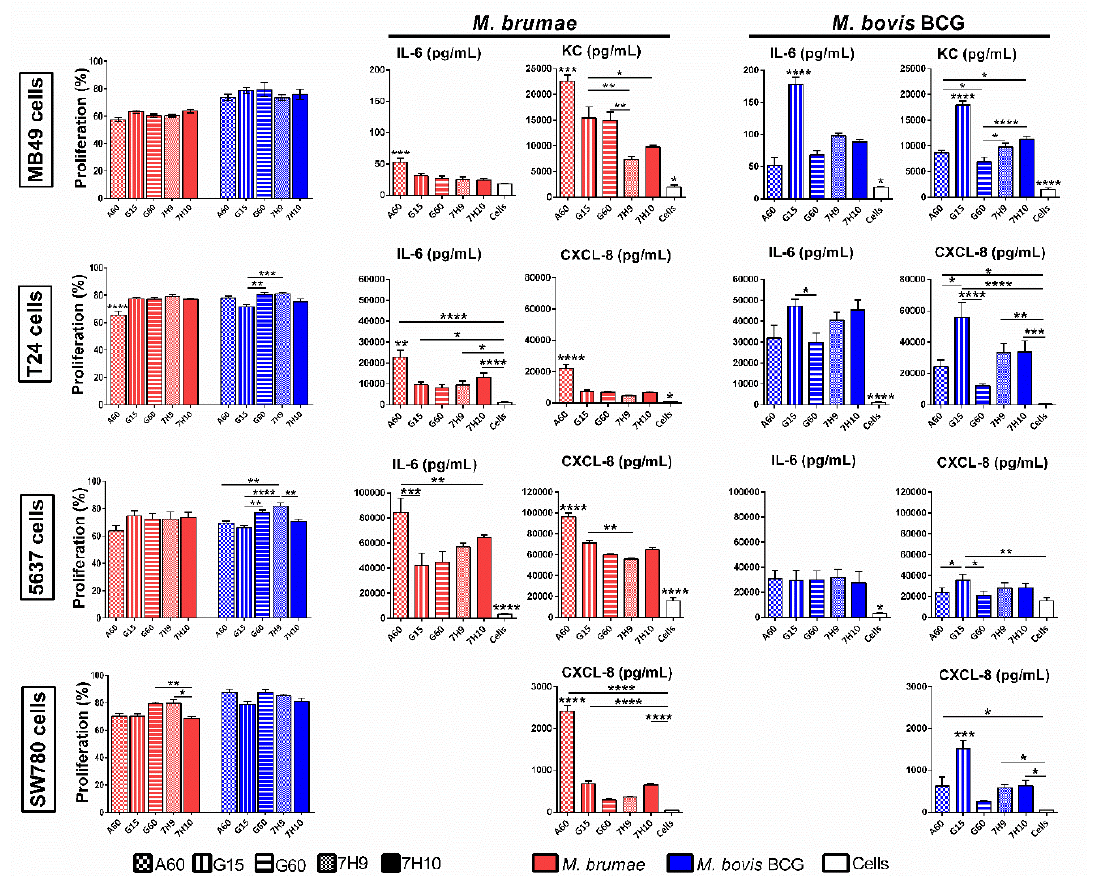
Figure 5. Cell growth inhibition and cytokine production by M. brumae and M. bovis BCG-infected bladder cancer (BC) cell lines. The antitumor effect of M. brumae (in red) and M. bovis BCG (in blue) grown in different culture media was evaluated on murine (MB49) and human (T24, 5637, and SW780) BC cell lines. Graphs show the percentage of growth inhibition with respect to non-infected cells using the 3-(4,5-dimethylthiazol-2-yl)-2,5-diphenyltetrazolium bromide (MTT) colorimetric assay. Cytokine production in cell culture supernatants collected 72 h after mycobacterial infection was evaluated using ELISA tests. Data represent the mean ± SD from at least three independent experiments. * p < 0.05; ** p < 0.01; *** p < 0.001; **** p < 0.0001 (ANOVA test).